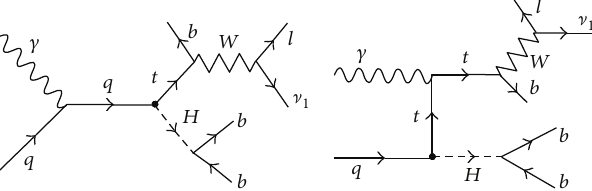
Figure 2: Tree level Feynman diagrams for the process 𝛾𝑞 → 𝑏𝑏 𝑡𝐻 → 𝑏ℓ + ] ℓ